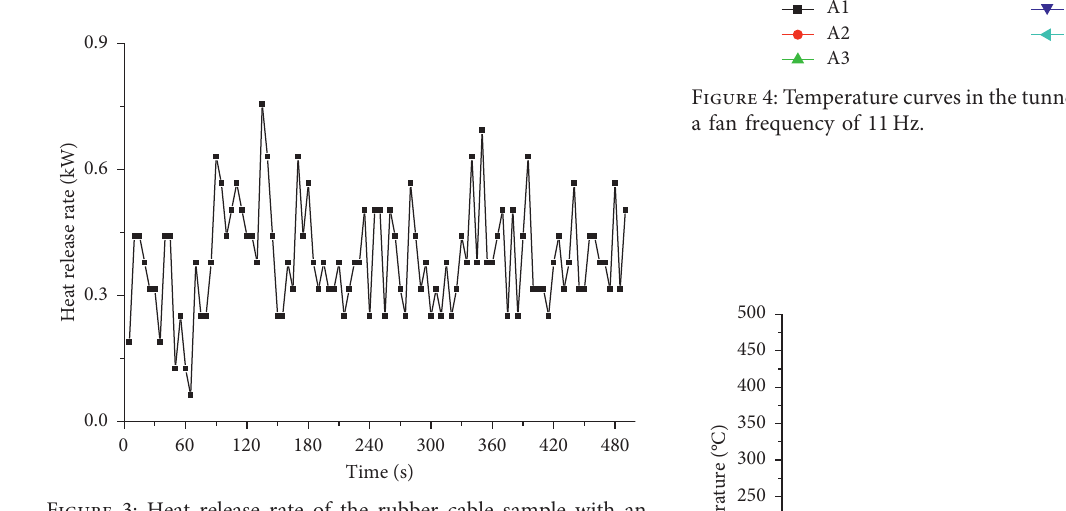
Figure 3: Heat release rate of the rubber cable sample with an airflow rate of 2m 3 /min.